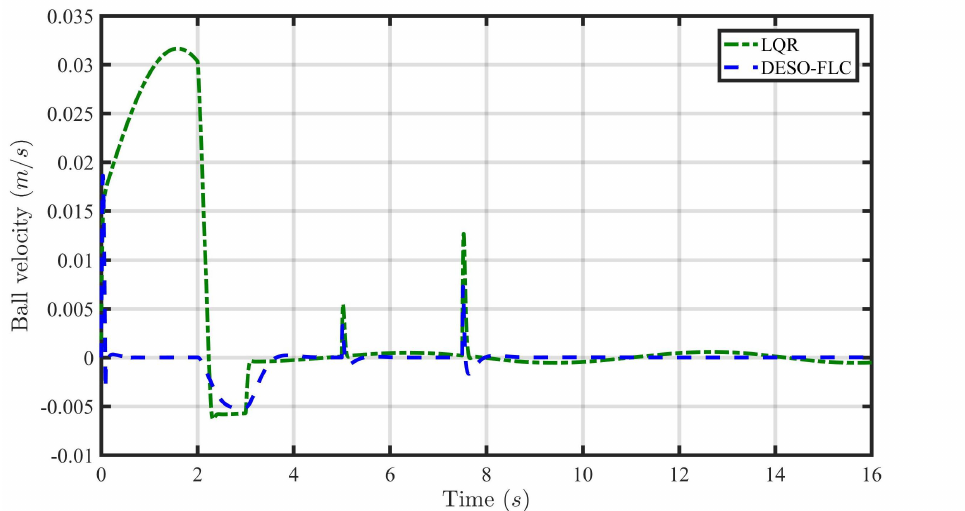
Figure 14. Response of steel ball velocity ( x 2 ) in the presence of payload disturbances and parametric